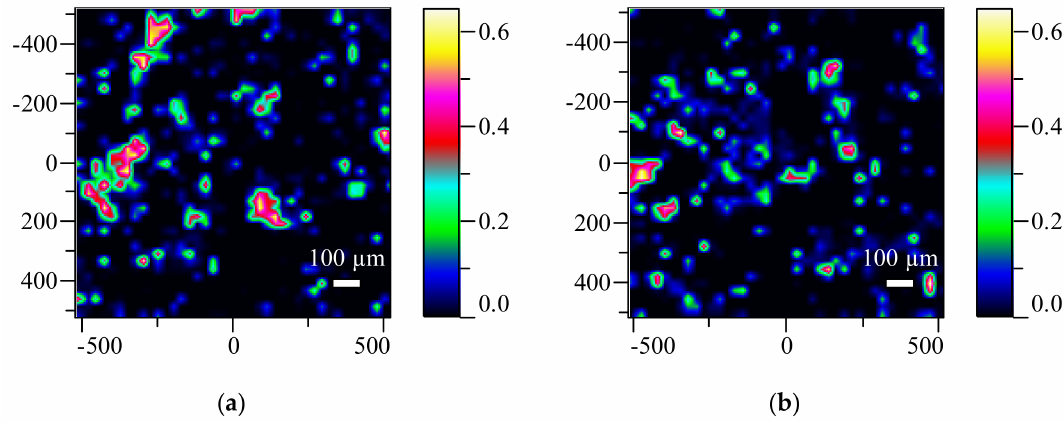
Figure 4. Raman maps of LSM ( a ) and HSM ( b ) ES tablets (colorful images show the distribution of the PVPVA64